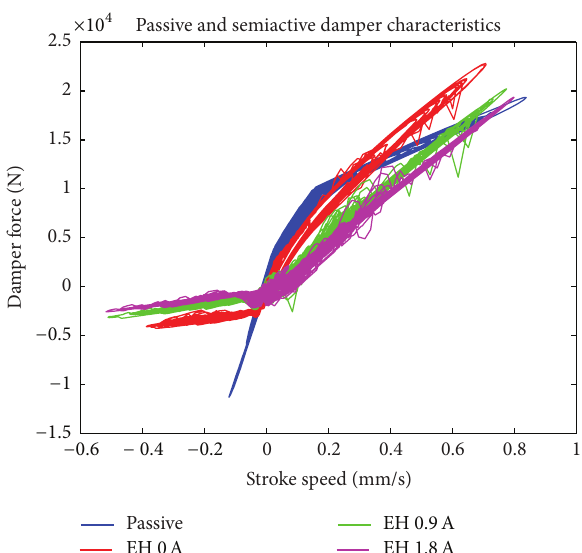
Figure 4: EH and passive damper characteristics.